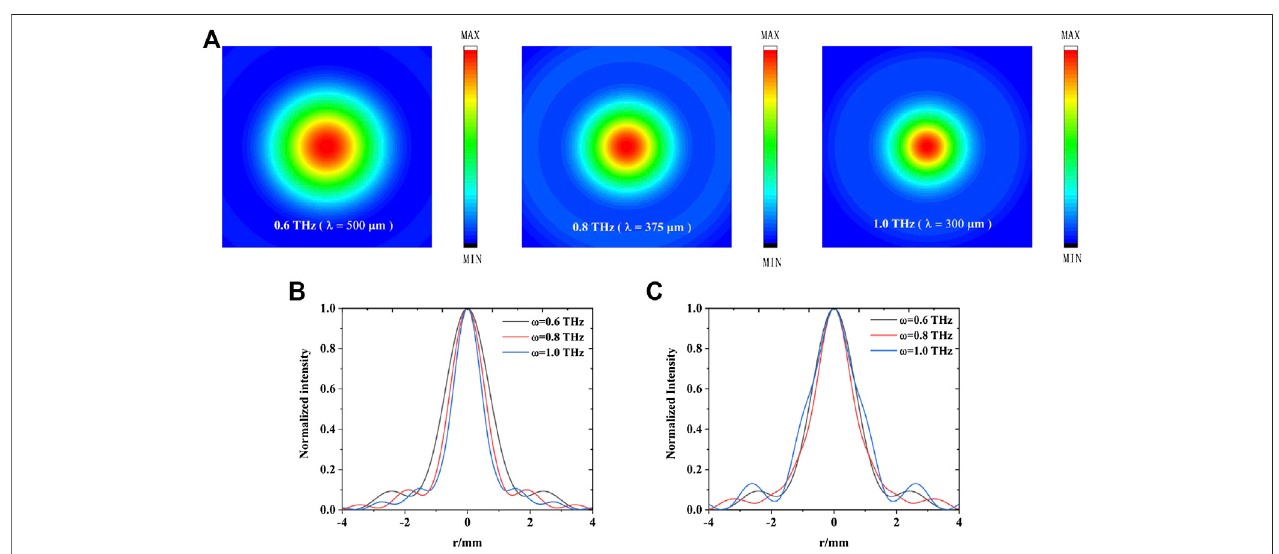
FIGURE 5 | (A) The simulated focal spots of the achromatic meta-lens at 0.6, 0.8, and 1.0 THz of the achromatic meta-lens. (B) The horizontal cuts of the focal spots for achromatic meta-lens at 0.6 THz (black), 0.8 THz (red), and 1.0 THz (blue). (C) The horizontal cuts of the focal spots for the chromatic counterpart at 0.6 THz (black), 0.8 THz (red), and 1.0 THz (blue), respectively.